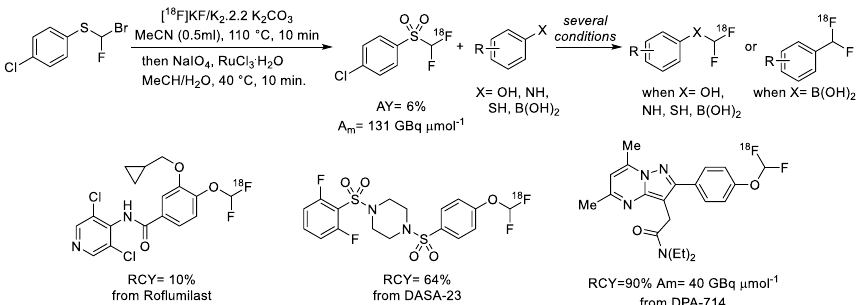
Fig. 6 Schematic overview of [ 18 F]difluorocarbene precursors obtained through a halogen exchange 18 F/Br of (bromofluoromethyl)(4-chlorophenyl)sulfane starting material, followed by an oxidation step. Examples of produced 18 F-radioligands are